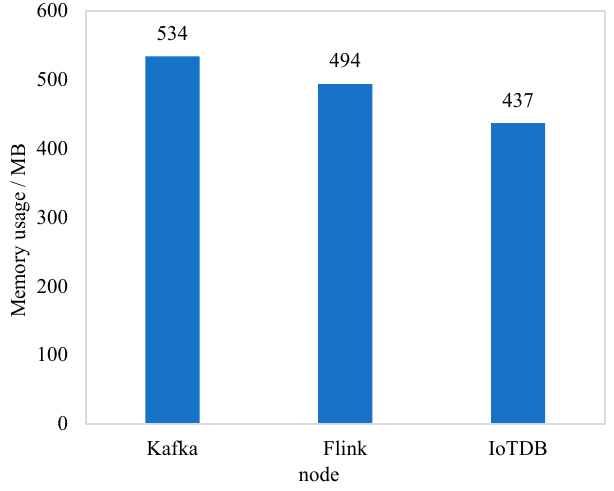
Figure 9. Memory usage of each node under the real dataset.